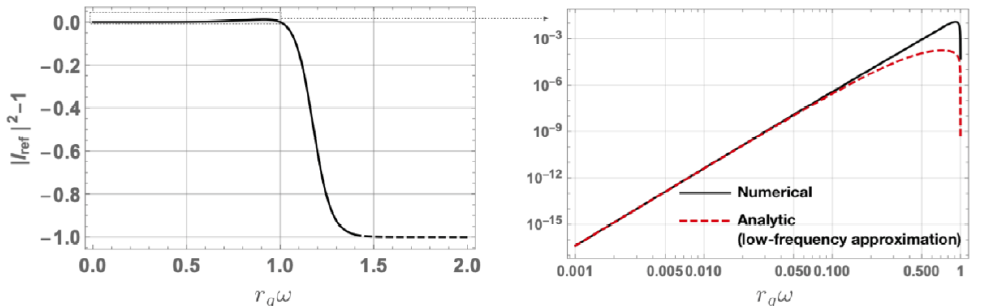
Figure 10. The amplification factor for ¯ a = 0.8 and (cid:96) = m = 2. In the right panel, low frequency region (solid) is calculated with the potential and the higher frequency region (dashed) is calculated V − 1, + 1 from in the CD V + 1, − 1